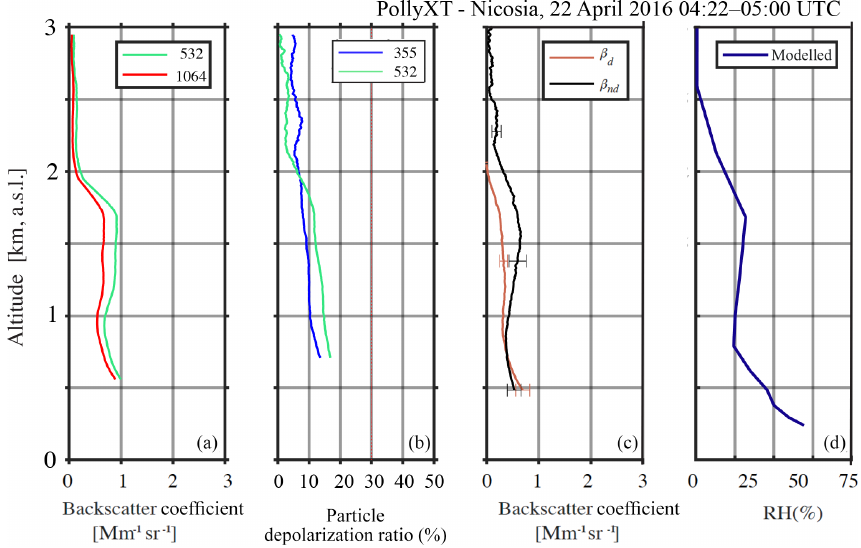
Figure 10. Daytime profiles of β (532 and 1064nm wavelength) (a) , δ p (355 and 532nm wavelength) (b) , β d and β nd (c) determined by POLIPHON, as well as RH profiles from WRF-ARW model over Nicosia at 04:00UTC (d) . The 355nm channel of the lidar was discarded due to